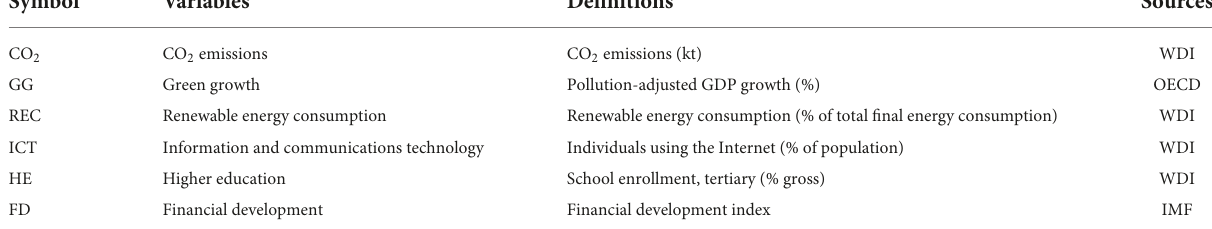
TABLE 1 Definitions and data